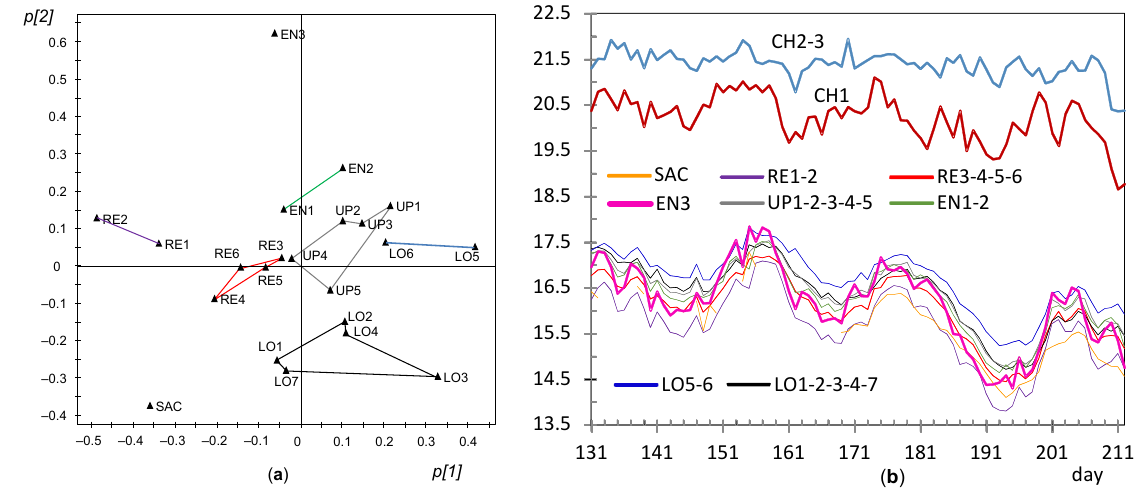
Figure 23. PCA of daily medians for the period of days 131–212 after discarding nodes OUT, CH1, CH2, and CH3: ( a ) loading plot for PC1 and PC2, ( b ) time series of daily median temperatures from day 131–212. Trajectories were averaged according to clusters indicated in ( a ).